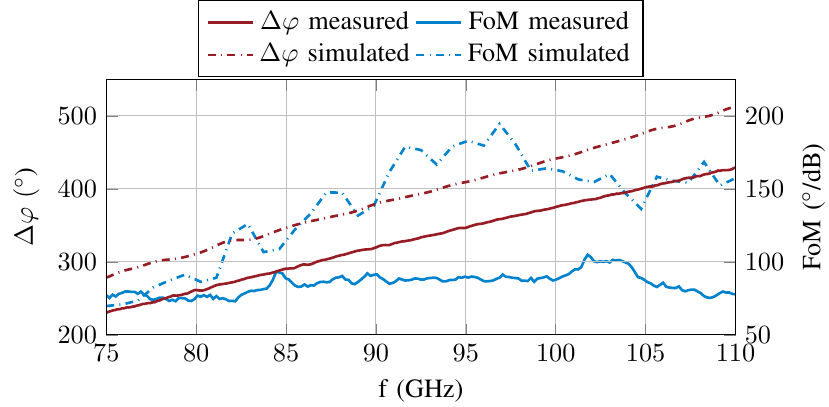
Figure 13. Measured and simulated differential phase shift and FoM of the SIF phase